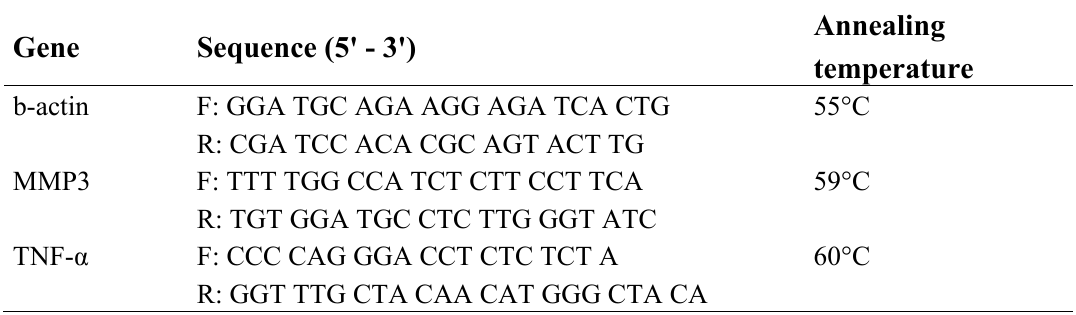
Table 3. Primer sequences and conditions for real time PCR